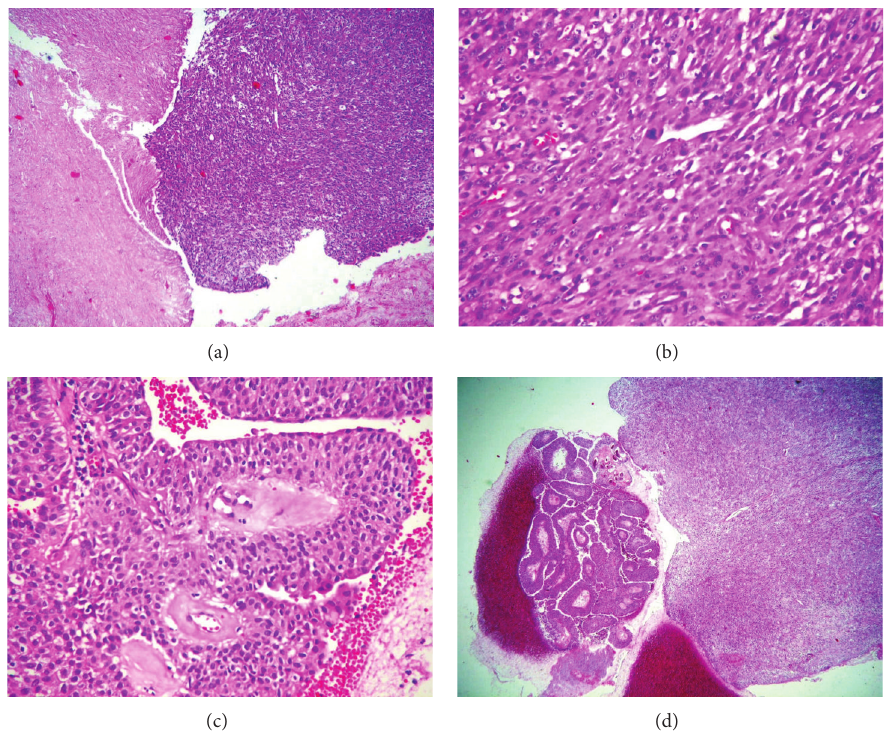
Figure 2: (a) Microscopic overview of the malignant urothelial tumor with epithelial and sarcomatoid components (H-E, × 5). (b) Papillary urothelial carcinoma (H-E, × 30). (c) Sarcomatoid component of the tumor showing pleomorphic, spindle cells. There is atypical mitotic figure in centre of tumor (H-E, × 30). (d) Large size of necrosis in sarcomatoid tumor (H-E, ×